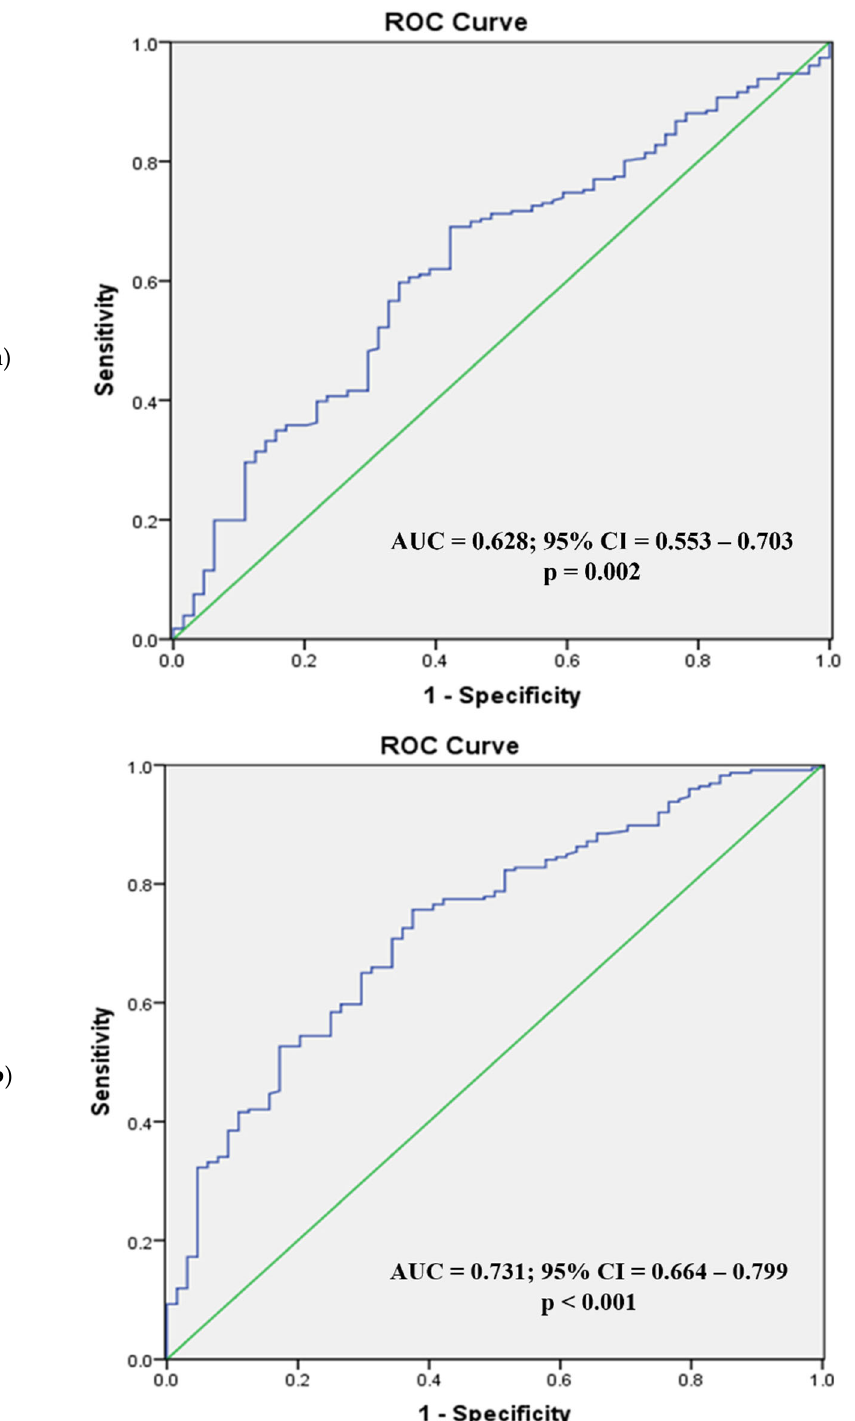
Figure 5. Receiver operating characteristic analysis of women with high BMI (body surface area ( a ), body mass index ( b )). In high BMI women, the AUC for BSA ( a ) was 0.628 (95% CI = 0.553–0.703; p = 0.002) and for BMI ( b ) 0.731 (95% CI = 0.664–0.799; p < 0.001). ROC, receiver operating characteristic; AUC, area under the curve; CI, confidence interval. In normal-weight men, the AUC for BSA was 0.626 (95% CI = 0.559–0.693; p < 0.001), and for BMI it was 0.719 (95% CI = 0.659–0.779; p < 0.001). The optimal cutoff value for BSA was 1.72 m 2 , with the highest sensitivity (59.4%) and specificity (60.8%), while the optimal cutoff value for BMI was 22.5 kg/m 2 (sensitivity, 74.3%; specificity, 63%). For men